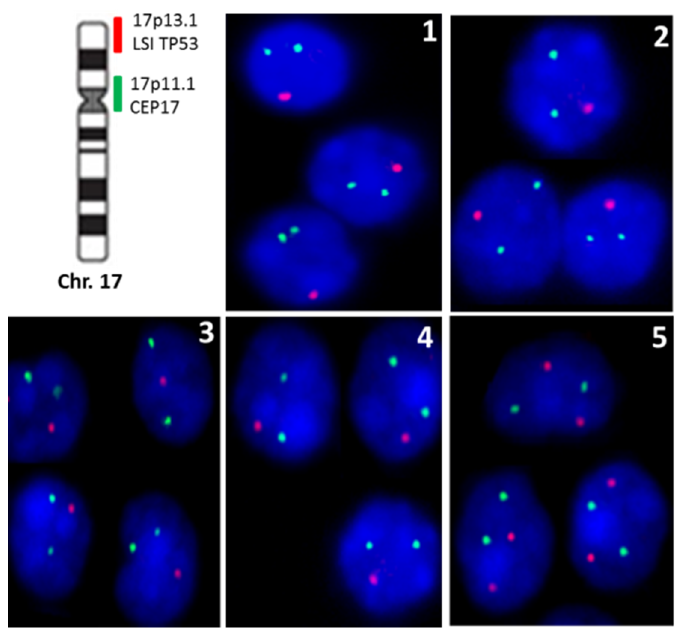
Figure 5. Representative pictures of cell nuclei from 5 PTT patients after hybridization with two probes for chromosome 17 (17p11.1 and 17p13; green and red signals, respectively). Four tumors showed loss of TP53 gene (Cases 1–4). Case 5 displayed a normal diploid number of hybridization signals for the both probes analyzed.